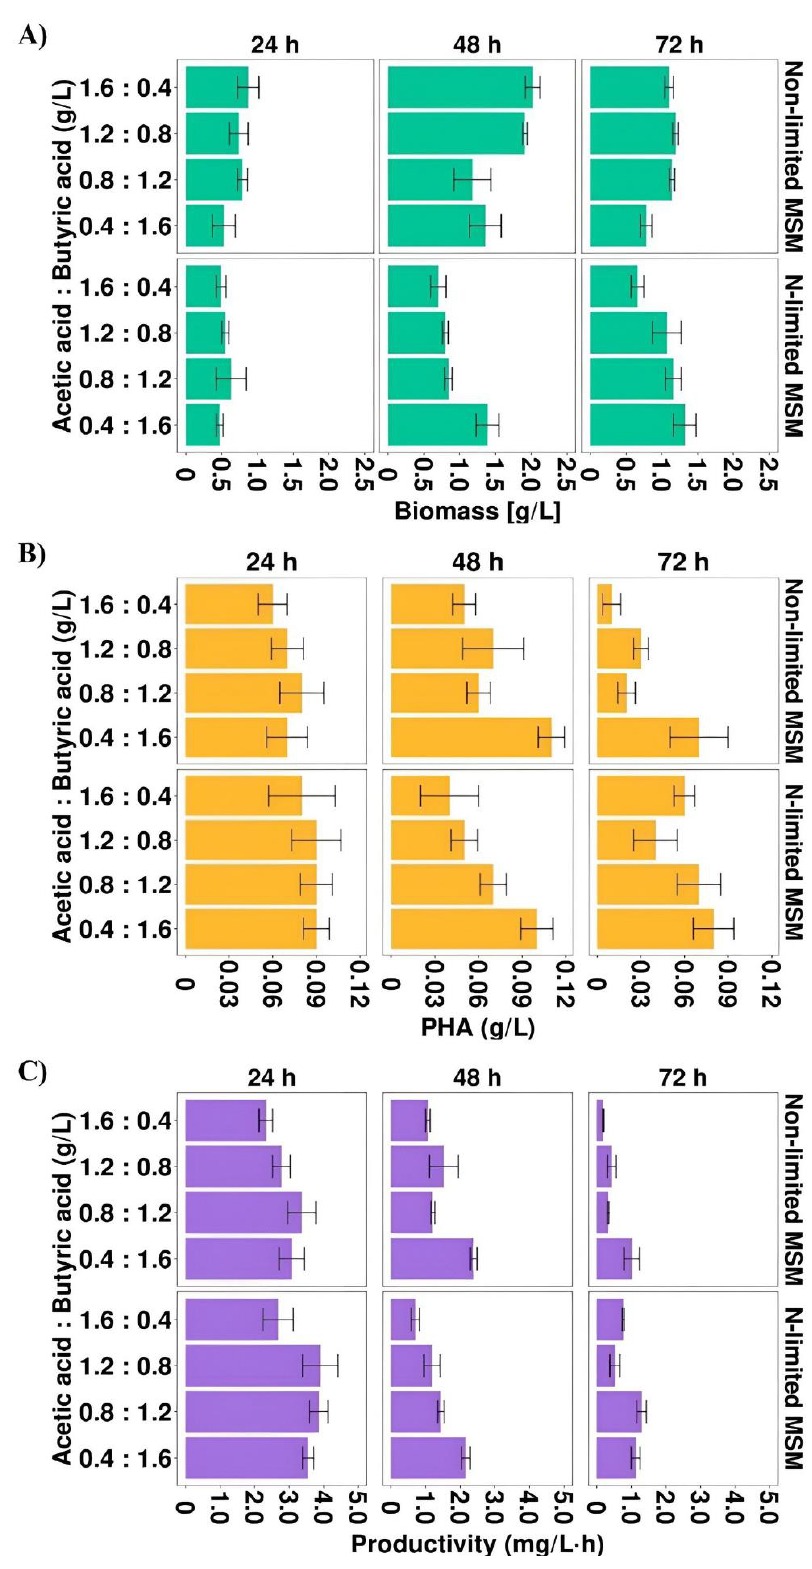
Figure 2. ( A ) Biomass concentration, ( B ) PHA concentration and ( C ) PHA productivity profiles of Aeromonas sp. AC_01 cultivated on the mixture of acetic and butyric acid. Abbreviations: non-limited MSM, non-limited mineral salt medium; N-limited MSM, nitrogen limited mineral salt medium.